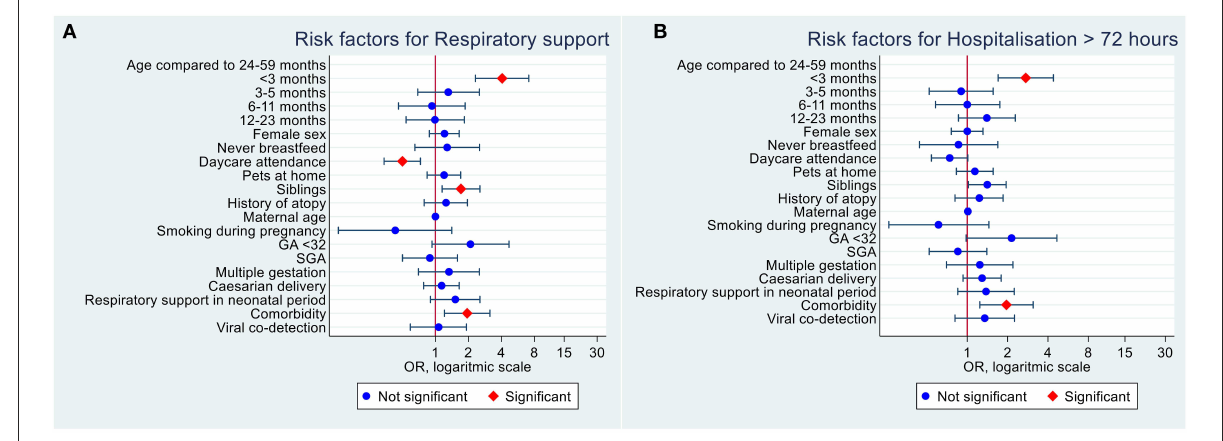
(Figure 1A). LOS > 72h was associated with young age and comorbidity status in the univariate analysis (Figure